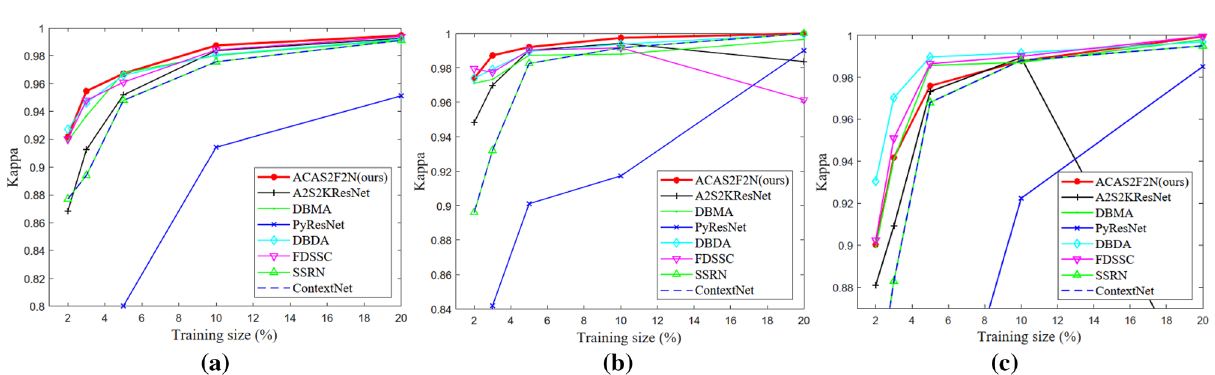
Figure 9. Kappa performance under different training sizes. ( a ) IP dataset. ( b ) KSC dataset. ( c ) Botswana